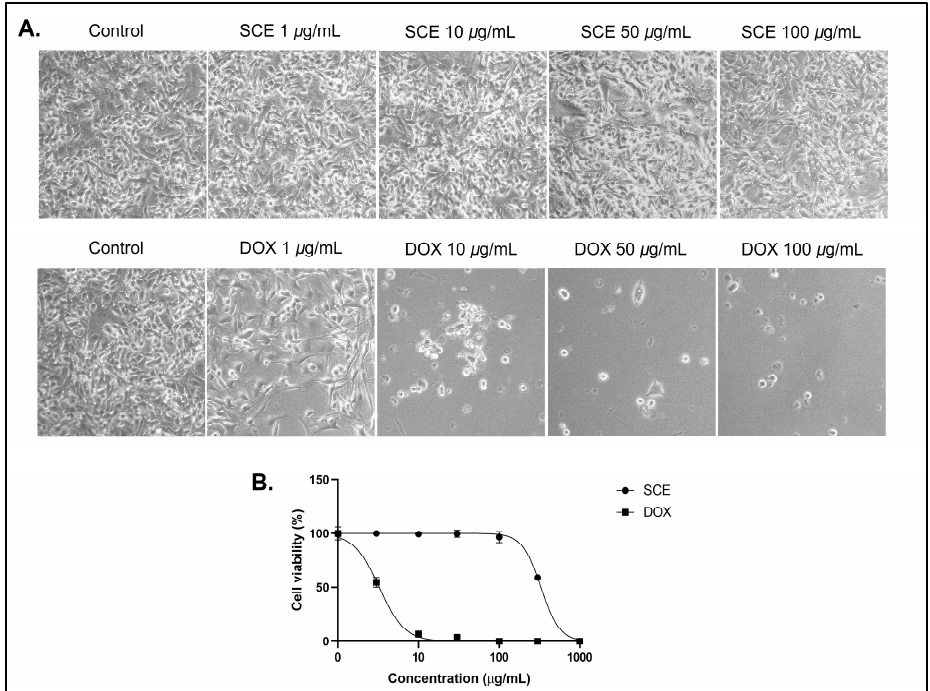
Figure 1. Cytotoxicity assay of SCE against B16-F10 cells for 48 h. ( A ) Morphological observations under a bright field microscope. ( B ) A dose–response curve showing no cytotoxic activity of SCE at the tested concentrations. The results are represented as the means of three independent experiments (SEM ± SD).